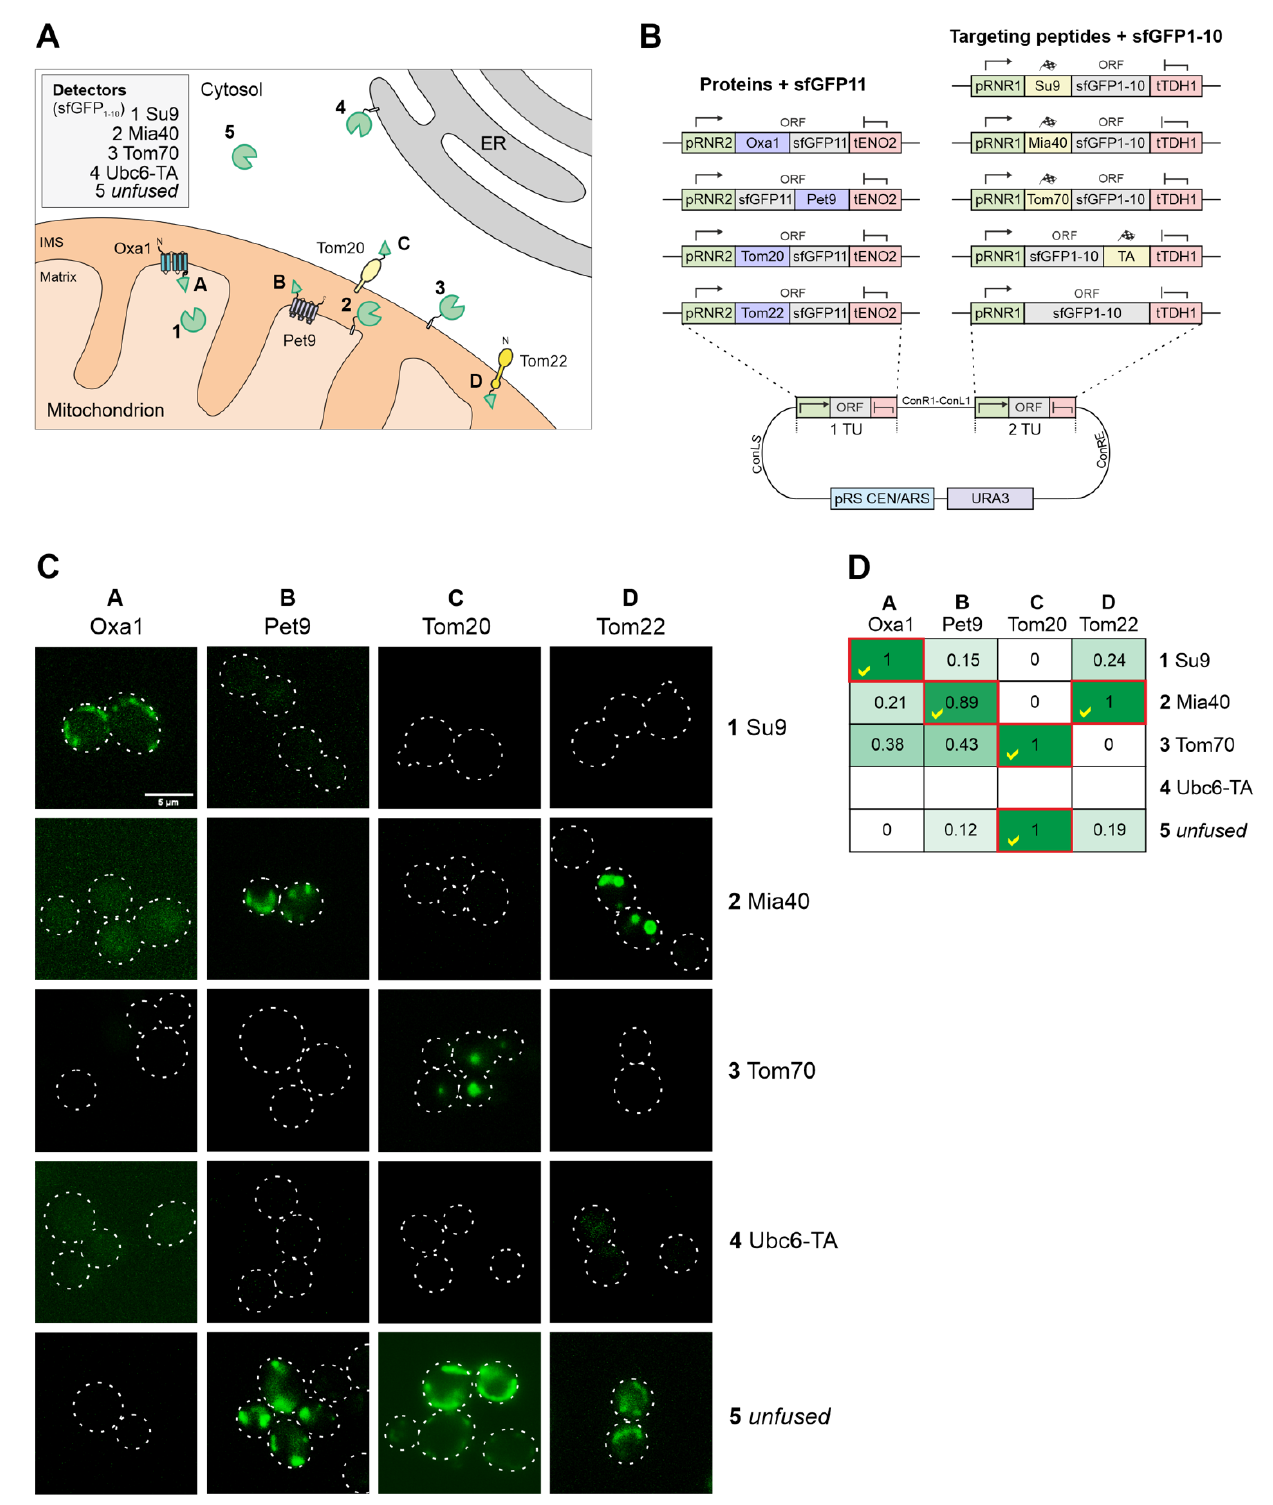
FIGURE 6: Different mitochondrial targeting signals direct proteins reliably to the different mitochondrial subcompartments. (A) Schematic representation of the different targeting signals and proteins used for fusions to sfGFP 1-10 and sfGFP 11 . (B) Schematic representation of the split GFP constructs used. The plasmids were created using the cHHYTK15 plasmid as described in the Materials and Methods section. The expression of proteins from the RNR1 promoter is comparable to that from the RNR2 promoter [14]. (C) YPH499 wild type cells were ex- pressed with the respective plasmid pairs, grown in glucose containing medium to mid-log phase and analyzed by fluorescence microscopy. Representative images are shown. Scale bar, 5 µm. (D) The fluorescence in the different cells was measured by fluorescence spectroscopy in a microtiter plate reader. The maximum intensity of constructs 1-5 were set to 1 (except for the Ubc6-TA sample for which only background fluorescence was measured). The correct matching combinations are indicated by red frames and yellow check